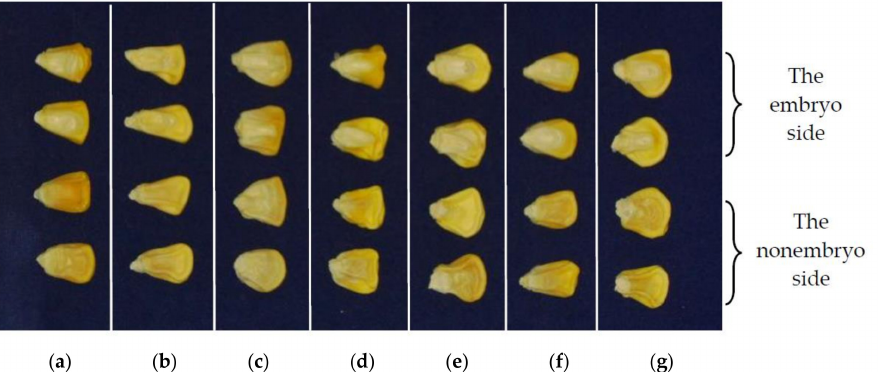
Figure 1. Images acquired from 7 cultivars of sweet corn seeds: ( a ) Orlando, ( b ) Beiyasi, ( c ) Jingketian 183, ( d ) Jingtian 218, ( e ) Suitian 1, ( f ) CT76, ( g )